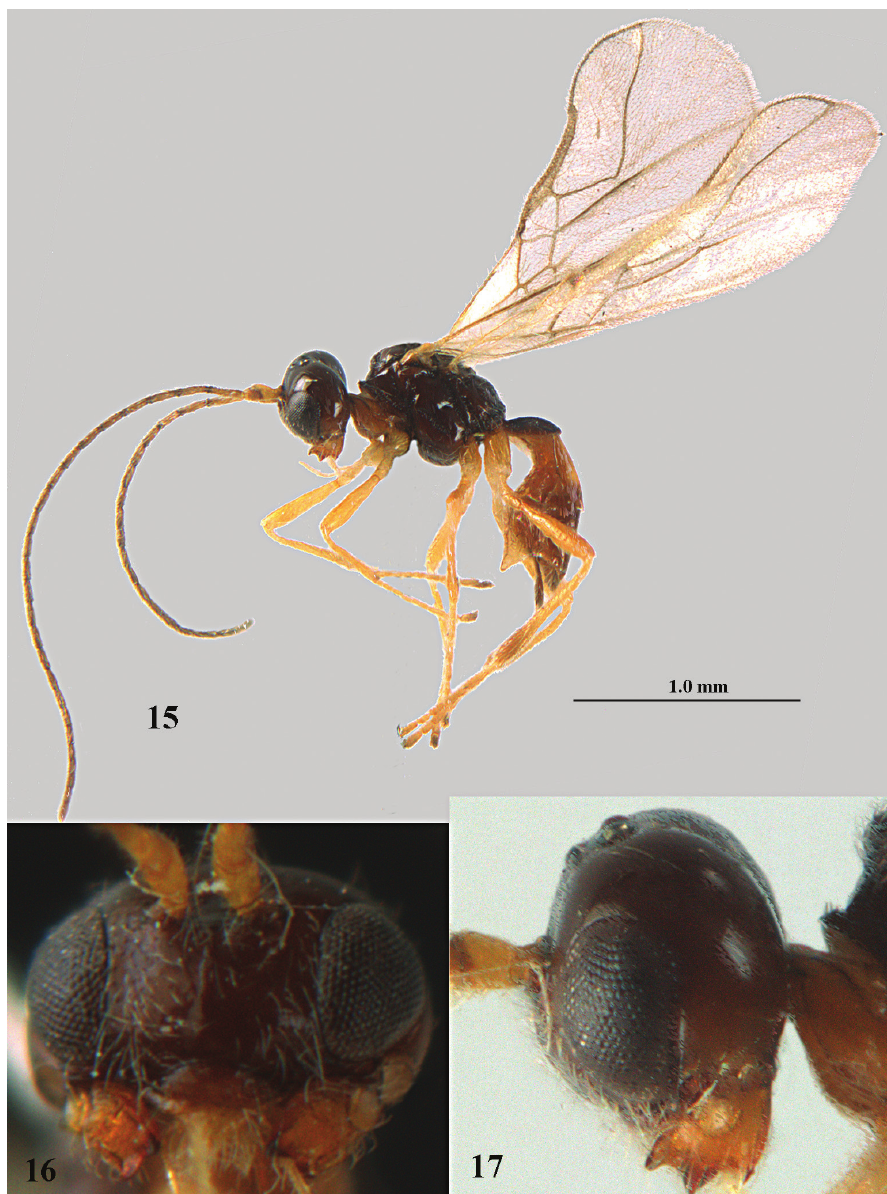
16 head, anterior aspect 17 head, lateral